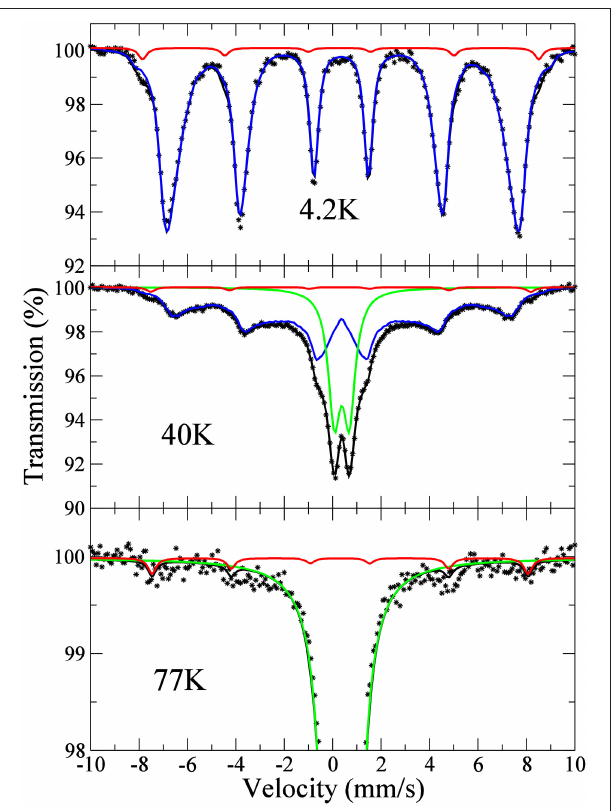
FIGURE 3 | 57 Fe Mössbauer spectra in lepidocrocite at selected temperatures; the lines are fits and show the decomposition in sub-spectra. The close-up of the 77 K spectrum focuses on the presence of the small (red line) component